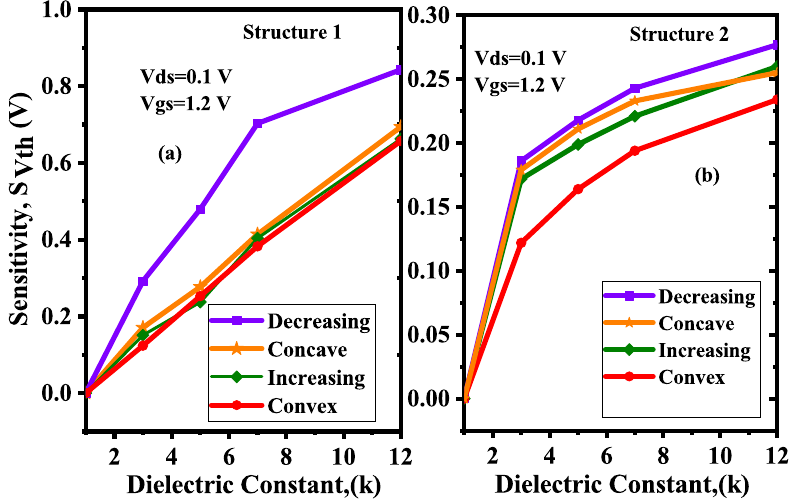
Figure 16. Sensitivity of the proposed DM-DG-TMD-FET-based biosensor for different filling profiles with biomolecules in the cavity ( V gs = 1.2 V , κ = 12 , N f = 0 ).